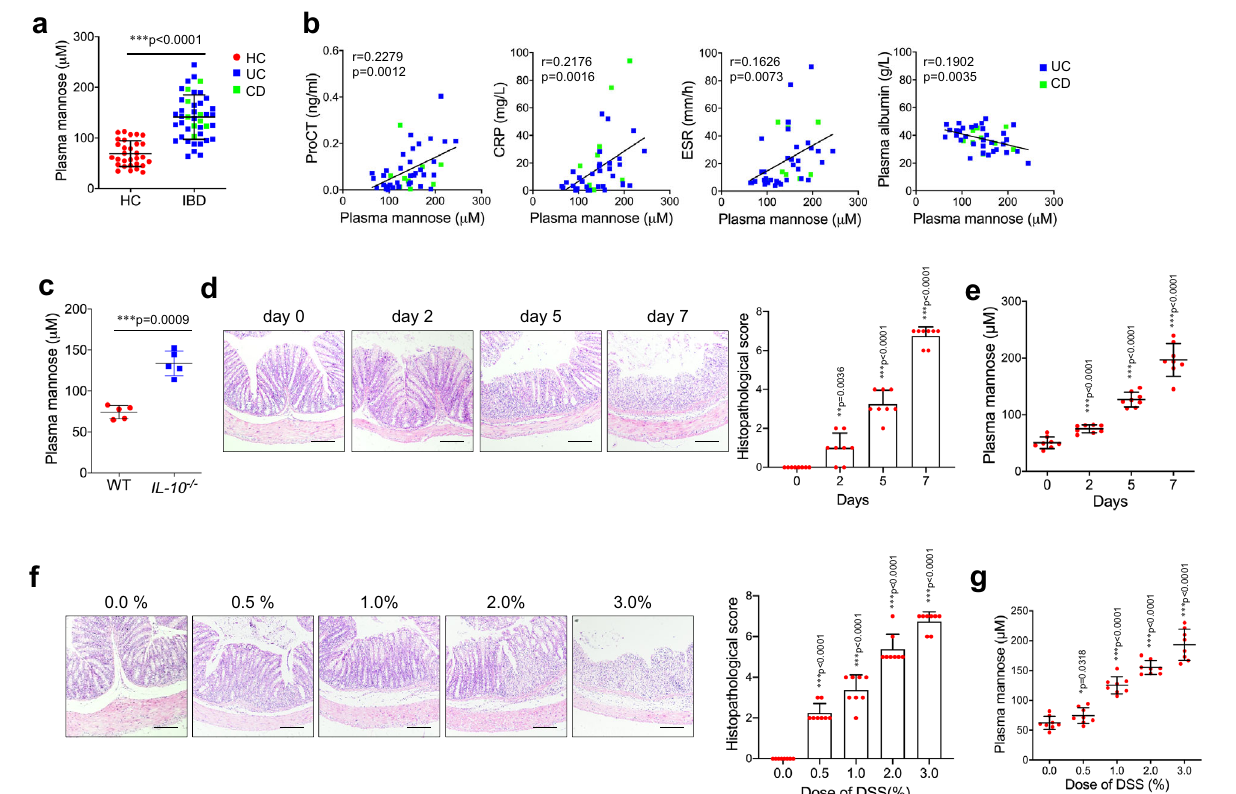
Fig. 1 | Mannose levels are increased in IBD patients and colitis model mice. a The plasma mannose concentration in HCs ( n =30) and patients with IBD ( n =44), including CD ( n =9) and UC ( n =35), was determined by LC – MS/MS. Error bars represent 95% con fi dence intervals. b The relationship of plasma mannose concentration with ProCT, CRP, ESR, and plasma albumin levels in IBD patients. c Themannoselevelinserumsamplesfrom19-week-oldWTmiceand IL- 10 − / − spontaneous colitis model mice ( n =5) were assessed by LC – MS/MS. d , e C57BL/6J mice ( n =8) received 3.0% DSS or tap water for the indicated days. d The colonic pathological changes were analyzed by H&E staining, and the